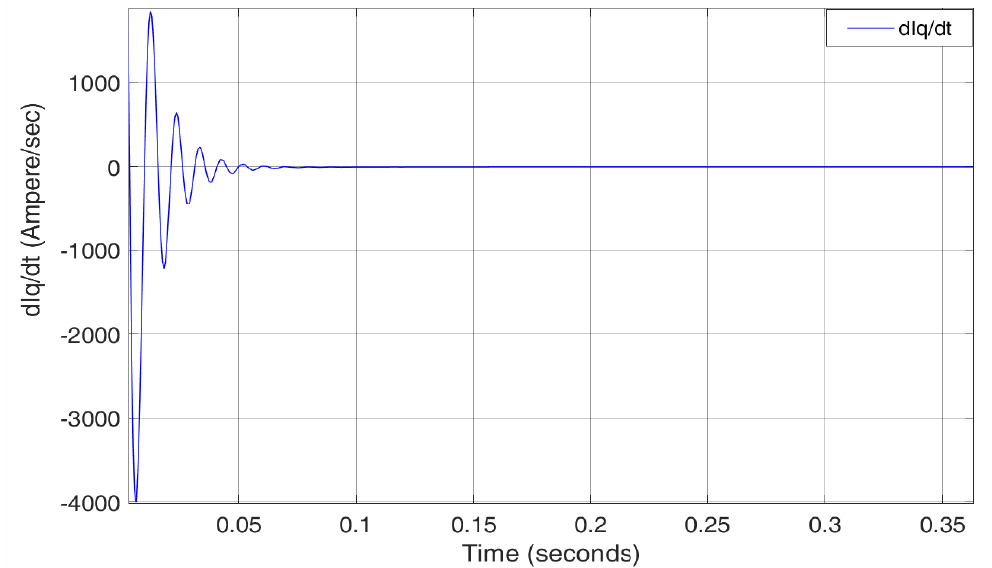
Figure 13. Derivative of Iq from URED at the nominal temperature of 20 ◦